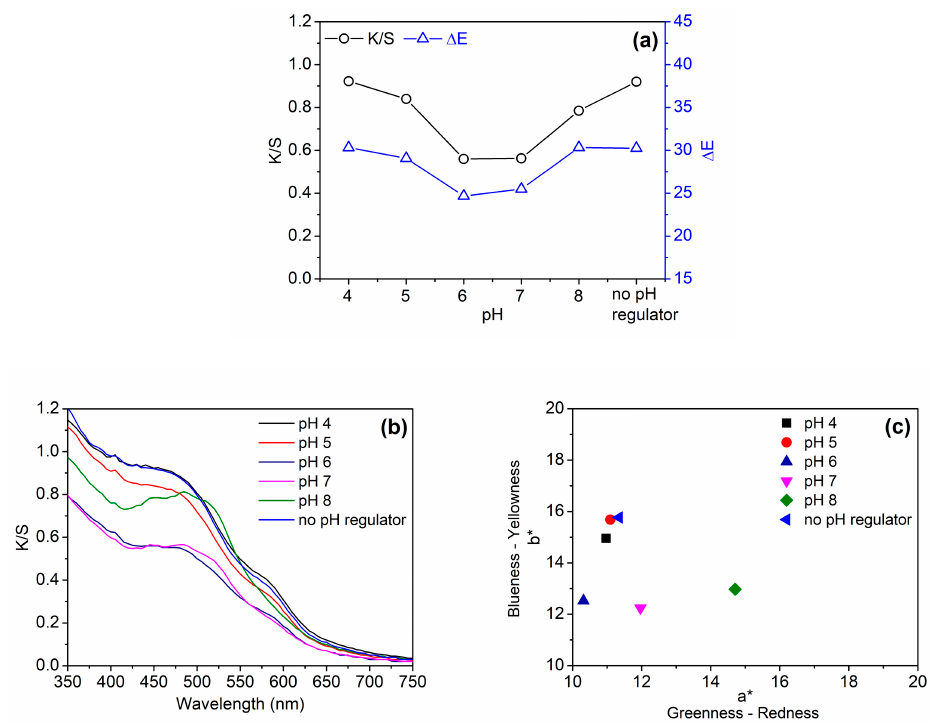
Figure 3. Color depth (K / S at 450 nm) and color di ff erence ( a ), visible absorption spectra ( b ), and chromaticity coordinates ( c ) of cotton fabrics dyed with 20%owf GSE at various pH values.